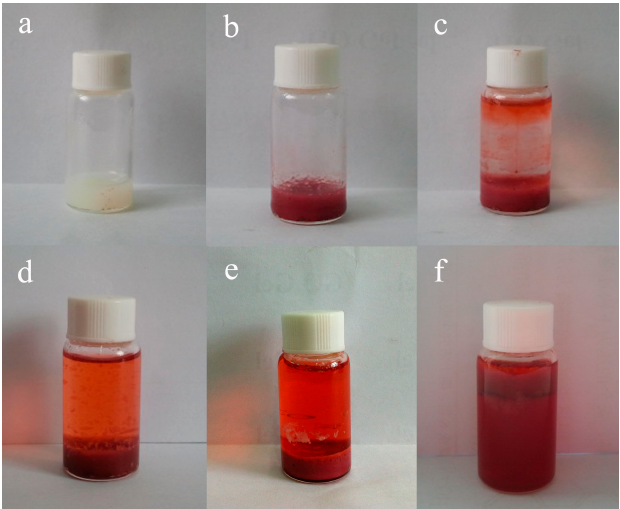
Figure 10. Photographs of release process of TC16-Fl organogels in n-pentanol with addition of CR (2 mg/mL): ( a ) as-formed organogel; ( b ) gel with addition of CR; ( c – f ) with water time of 10, 50, 200, and 500 min, respectively.